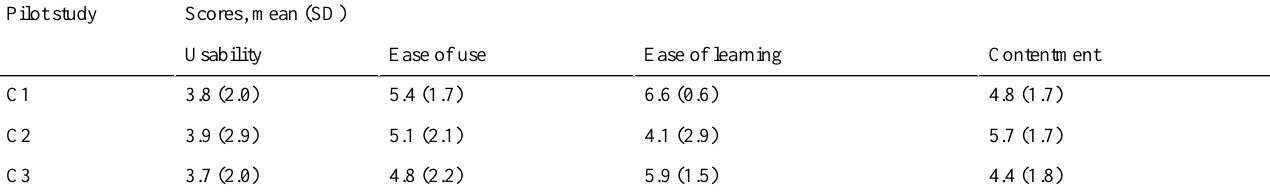
Table 2. The mean (SD) scores of the USE questionnaire in the various pilot studies. Scores, mean (SD)Pilot study